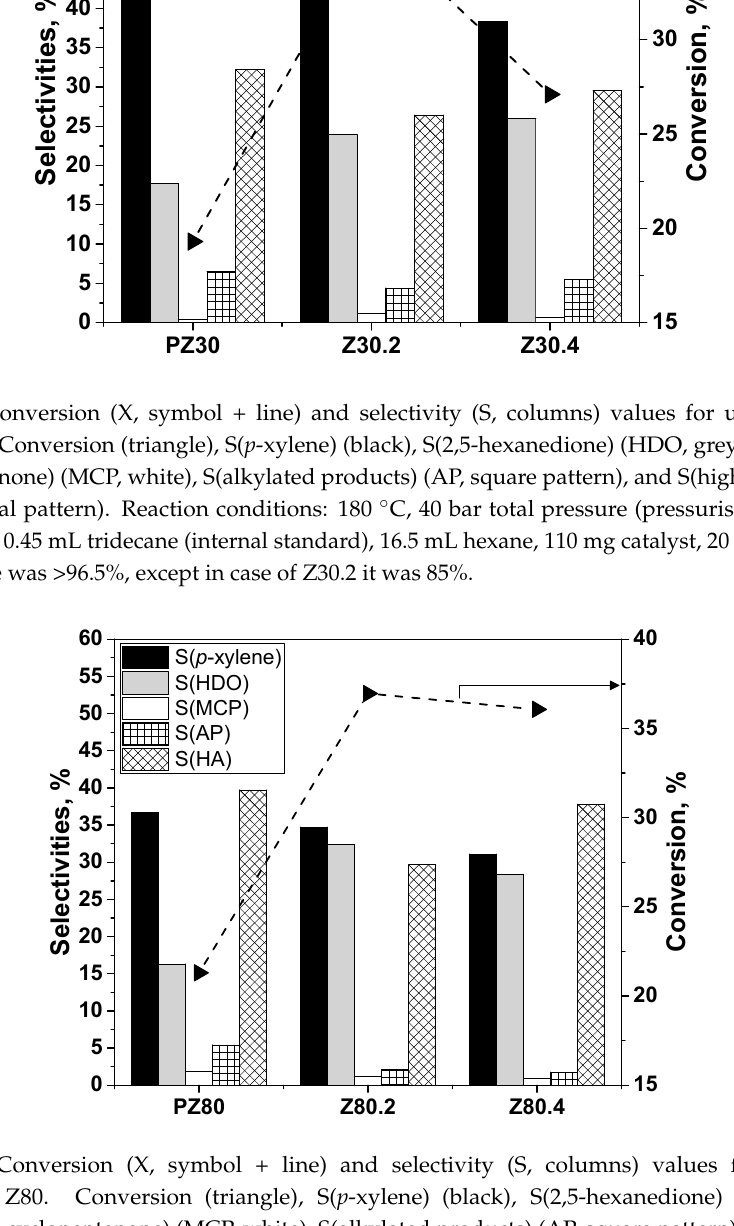
Figure 9. Conversion (X, symbol + line) and selectivity (S, columns) values for untreated and treated Z80. Conversion (triangle), S( p -xylene) (black), S(2,5-hexanedione) (HDO, grey), S(3-methyl-2-cyclopentenone) (MCP, white), S(alkylated products) (AP, square pattern) and S(higher aromatics) (HA, diagonal pattern). Reaction conditions: 180 °C, 40 bar total pressure (pressurised at 180 °C), 5.5 mL DMF, 0.45 mL tridecane (internal standard), 16.5 mL hexane, 110 mg catalyst, 20 h. The carbon mass balance was in all cases >94%.